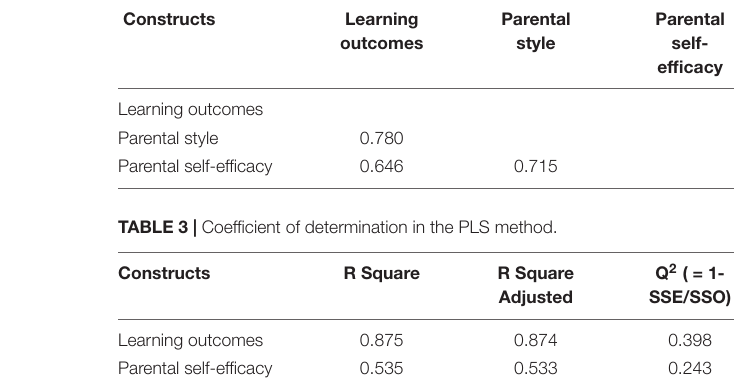
TABLE 2 | Discriminant validity through Heterotrait-Monotratit (HTMT).